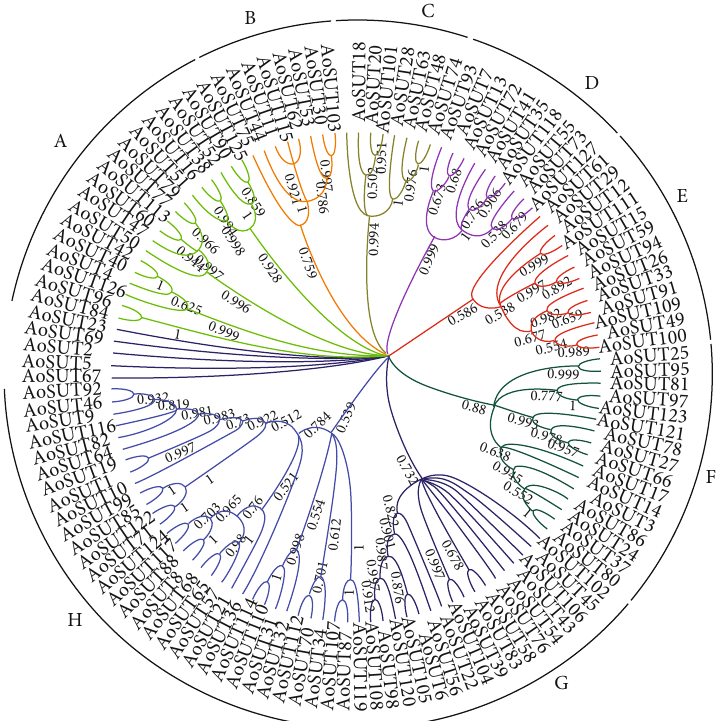
Figure 1: The phylogenetic relationship in A. oryzae SUT proteins. The maximum likelihood tree was constructed by the MEGA X with 1000 bootstrap replications. Eight clades were distinguished in di ff erent colors, and several unclassi fi ed genes were colored in